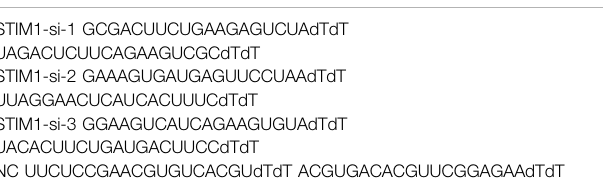
TABLE 2 | Three different nonoverlapping RNAi duplexes with the following sequences were obtained.